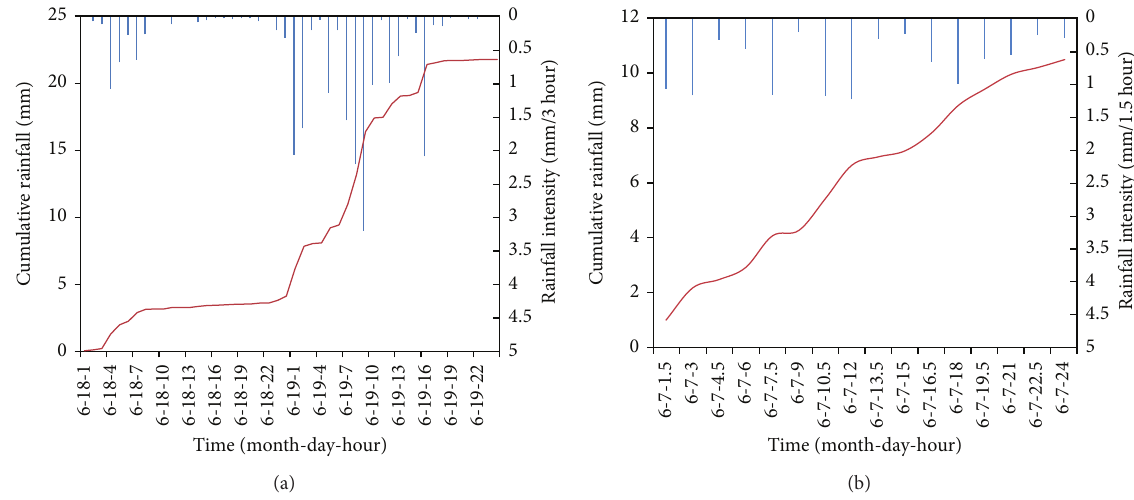
Figure 4: The time series bars and the cumulative curves of the observed precipitation for the two heavy rainfall events at Laohugou station: (a) Event A; (b) Event B.